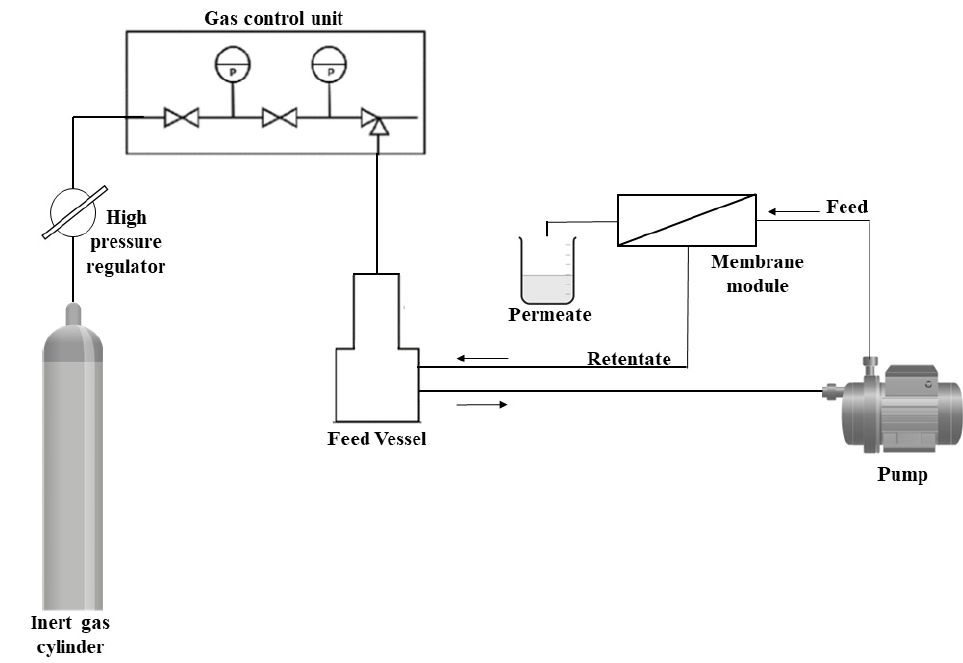
Figure 3. Experimental reverse osmosis setup using EVONIK METCell unit.